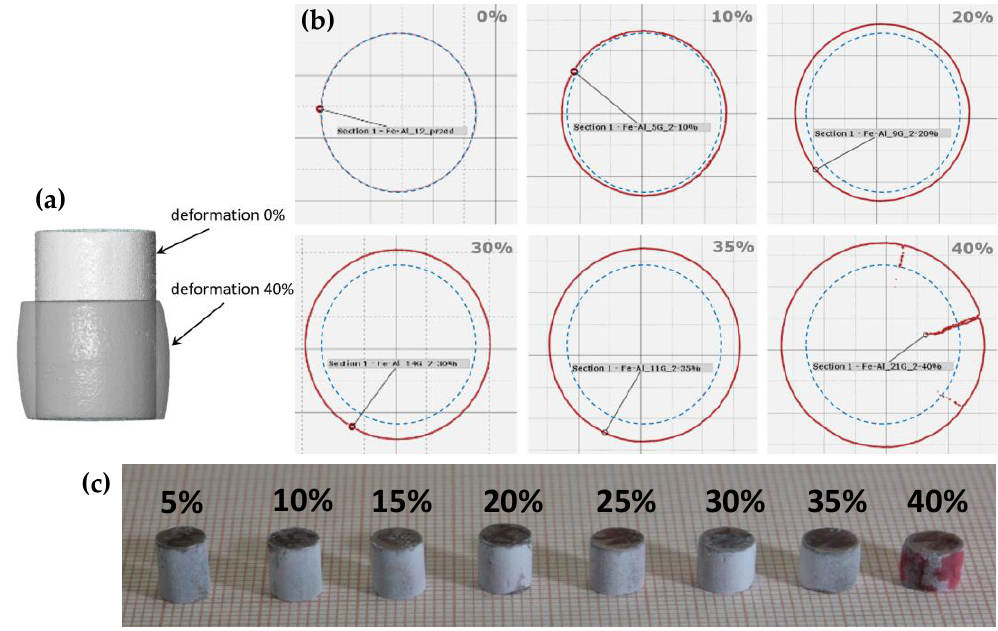
Figure 6. The changes in the outer contours of a sample after deformation ( a , b ); view of specimens after cracks detection using the penetrator method ( c ).